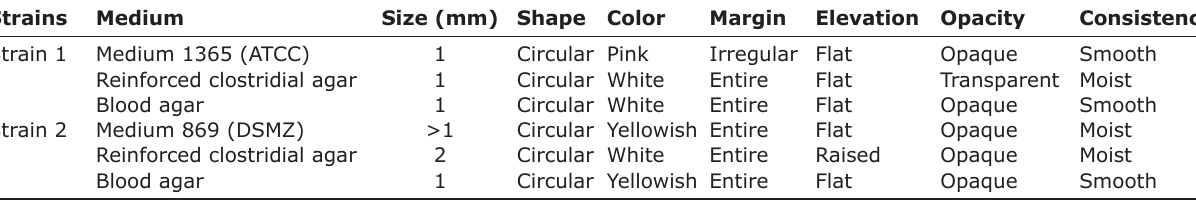
Figure-3: Phylogenetic analysis of (a) Streptococcus lutetiensis (Strain 1) and (b) Streptococcus bovis (Strain 2). Sequence alignment and phylogenetic analysis were performed by MEGA6 with a bootstrap method. The evolutionary distances were analyzed using the maximum composite likelihood method. Table-2: Colony characteristics of rumen Streptococcus species.